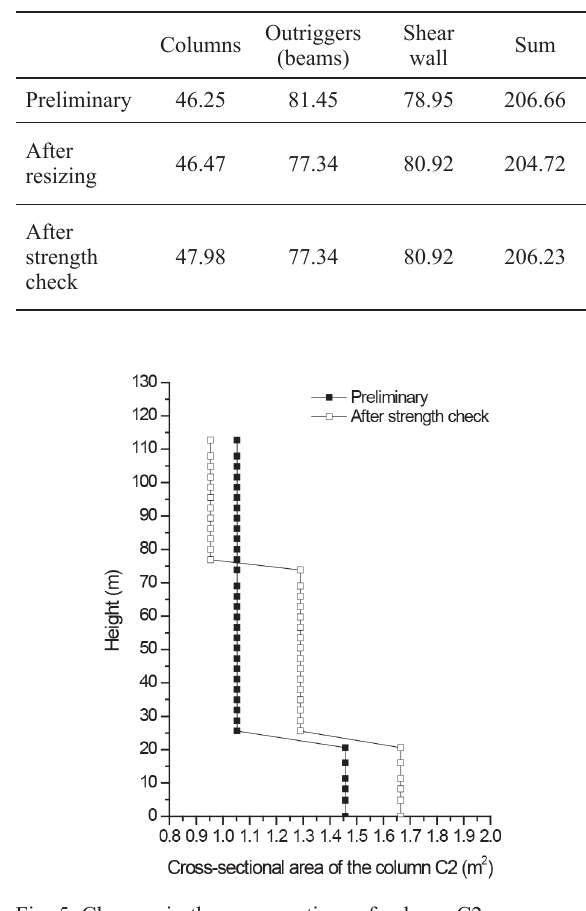
Fig. 5. Changes in the cross sections of column